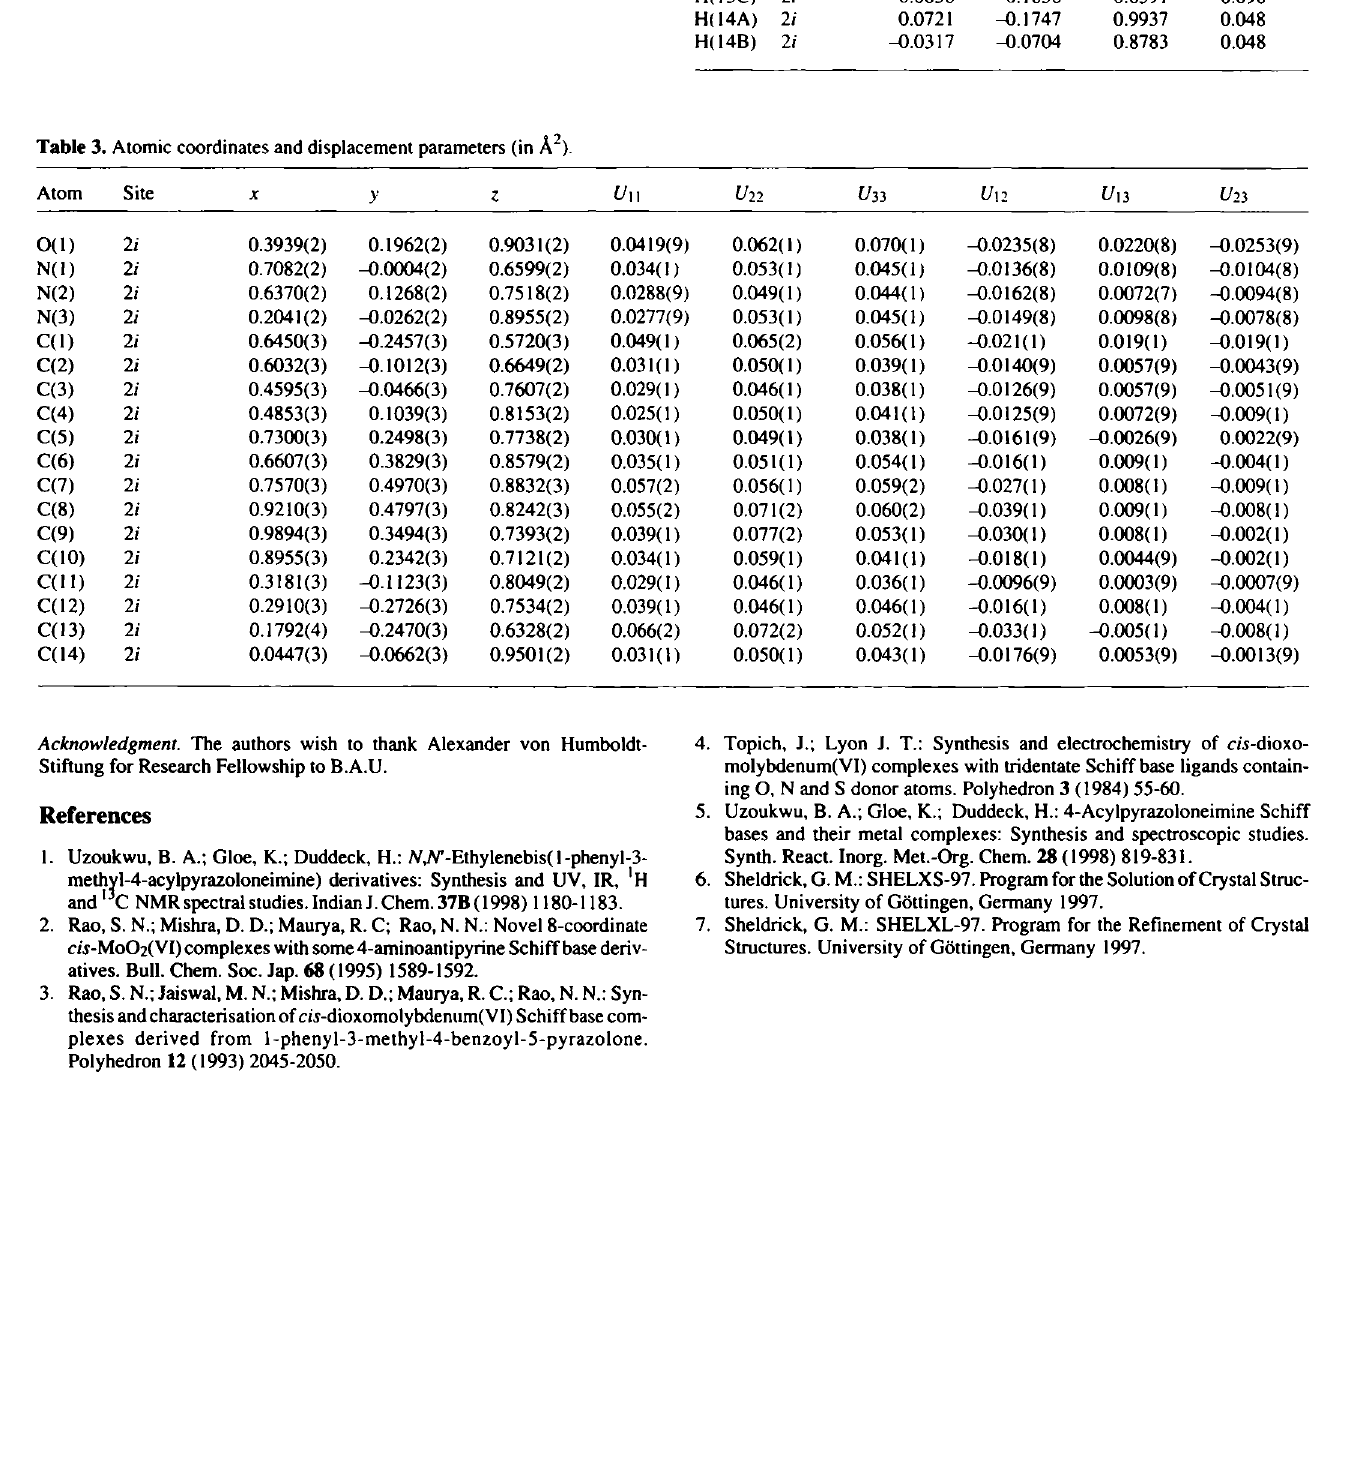
Table 3. Atomic coordinates and displacement parameters (in Ä 2